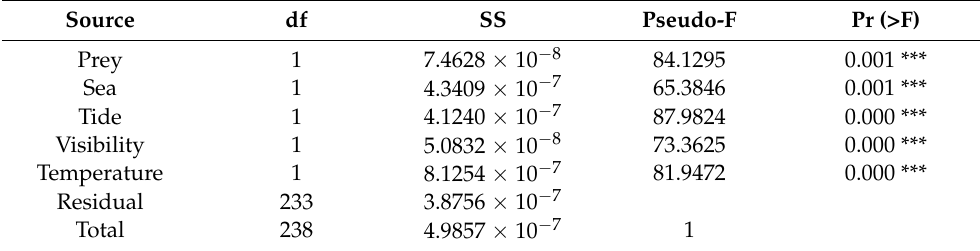
Table 2. PERMANOVA analysis between the elements ‘years’ and ‘effects’ across units, dealing with multicollinearity problems. Here, the labels stand for ‘degrees of freedom’ (df), ‘sum of squared dissimilarities’ (SS), ‘Pseudo F statistic’ (Pseudo-F), and ‘associated p -value’ (Pr (>F)). The significance level is: (***) significance at 1%. Source df SS Pseudo-F Pr (>F) Prey